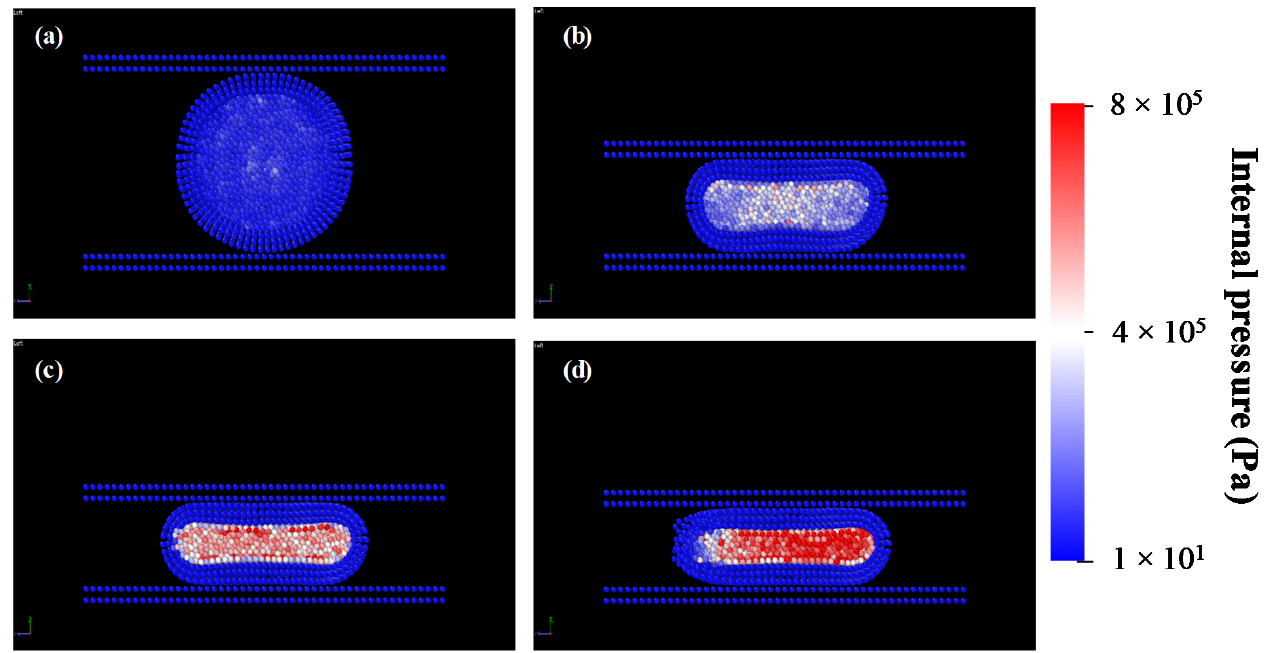
Figure 6. Simulation sequence of the parallel compression test of a single liquid core–shell capsule at different stages: ( a ) beginning of the simulation, ( b ) high deformation and slight increment of internal pressure, ( c ) slight deformation and significant increment of internal pressure and ( d ) fracture of the capsule.